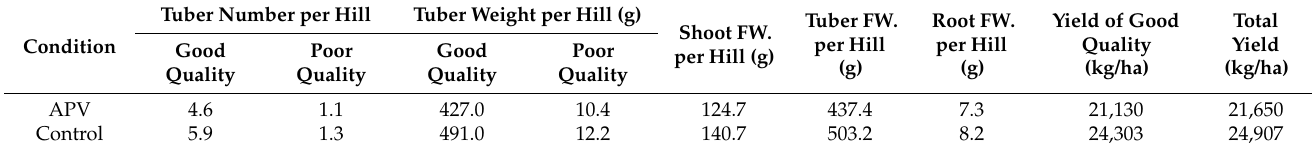
Table 3. Yield of potato underneath an agrophotovoltaic (APV) system in Cheongju, South Ko- rea, 2021.